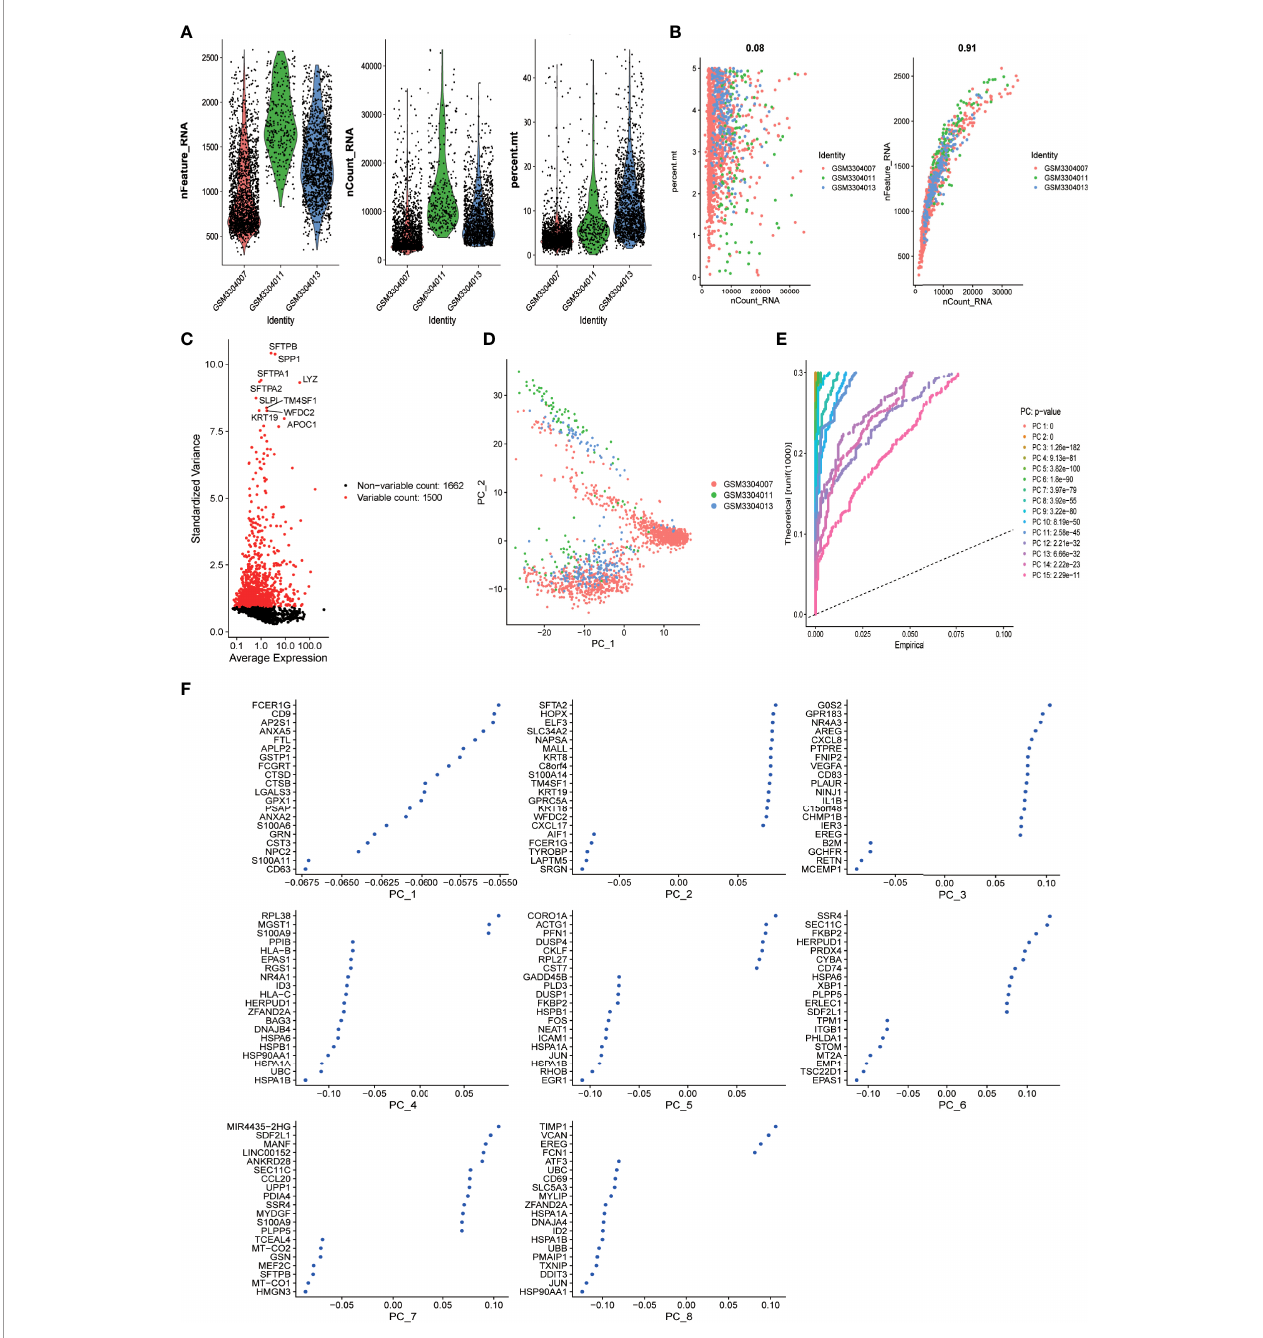
FIGURE 1 | scRNA-seq analysis identi fi ed eight clusters of LUAD cells (A) Violin plots demonstrate the sequencing depth (left), number of detected genes (middle), and percentage of mitochondria genome (right) in each single-cell samples. After quality control of the 3,183 cells from the tumor cores of three human LUAD samples, 1105 cells were included in the analysis. (B) Dot plot demonstrates the correlation between sequencing depth and percentage of mitochondrial genes across all the single-cell samples (left). Dot plot demonstrates the correlation between sequencing depth and total intracellular sequences (right). (C) Dot plot demonstrates the correlation variance of each gene expression across all the single-cell samples. A total of 3,162 genes throughout all cells of LUAD are shown in the variance diagram. A total of 1,500 genes found to be highly variable are denoted as red dots, and 1,662 genes without signi fi cant variation are represented by black dots. Gene symbols of the top 10 highly variable genes are shown. (D) Principal component analysis (PCA) cannot clearly separate LUAD cells. (E) PCA identi fi ed 15 principal components (PCs) with an estimated P value less than 0.05. (F) The dimensionality of the 15 PCs were reduced using the tSNE algorithm and successfully yielded eight cell clusters whose top 20 markers genes are shown in dot